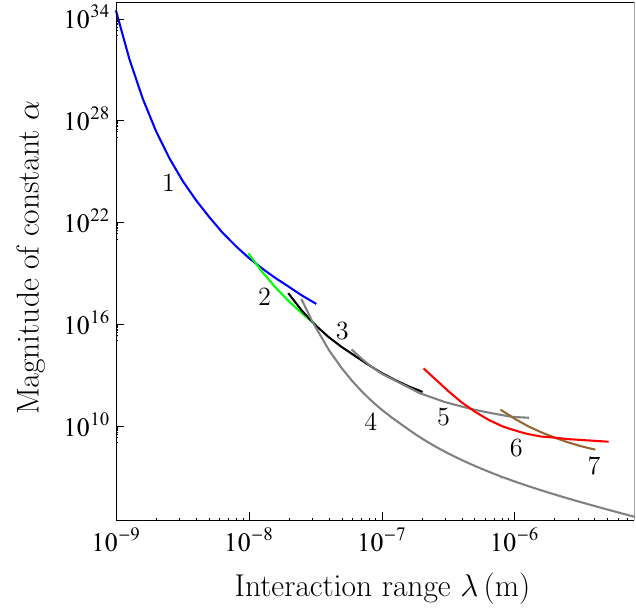
Figure 3. The constraints on Yukawa-type correction to Newton’s gravitational law following from measuring the lateral and normal Casimir forces between corrugated surfaces (lines 1 and 2, respectively), the effective Casimir pressure (line 3), from the second and first Casimir-less experiments (lines 4 and 5, respectively), from sensing the difference of lateral forces (line 6), and from the torsion-pendulum experiment (line 7) are shown as functions of the interaction range. The regions above each line are excluded and below each line are